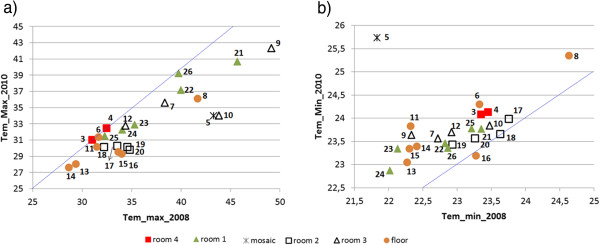
Bivariate plot of daily maximum (Tmax) and minimum (Tmin) temperatures in 2010 vs. 2008. Bivariate plot of Tmax (a) and Tmin (b) recorded from each probe in 2010 vs. 2008 (monitoring period: 14th to 31st of August). The tilted line is the bisector.